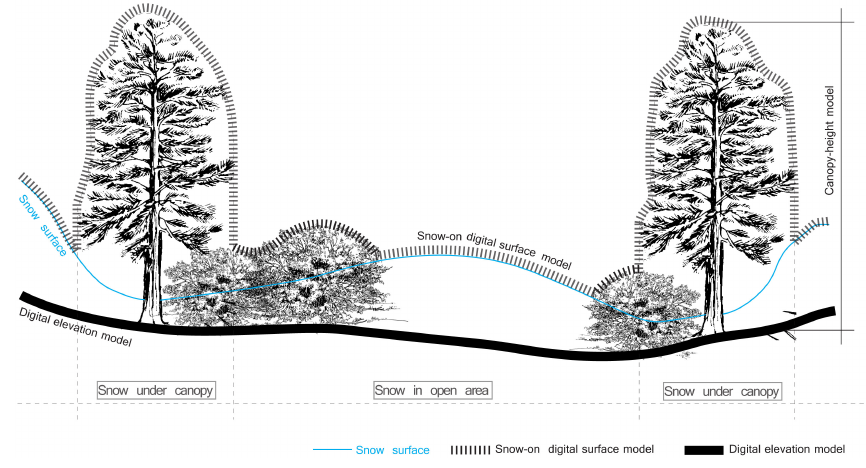
Figure 2. Subtracting the digital elevation model from the digital surface model will result in the canopy-height model. In this study the height of shrub vegetation is assumed smaller than 2m, while tree vegetation is taller than 2m.